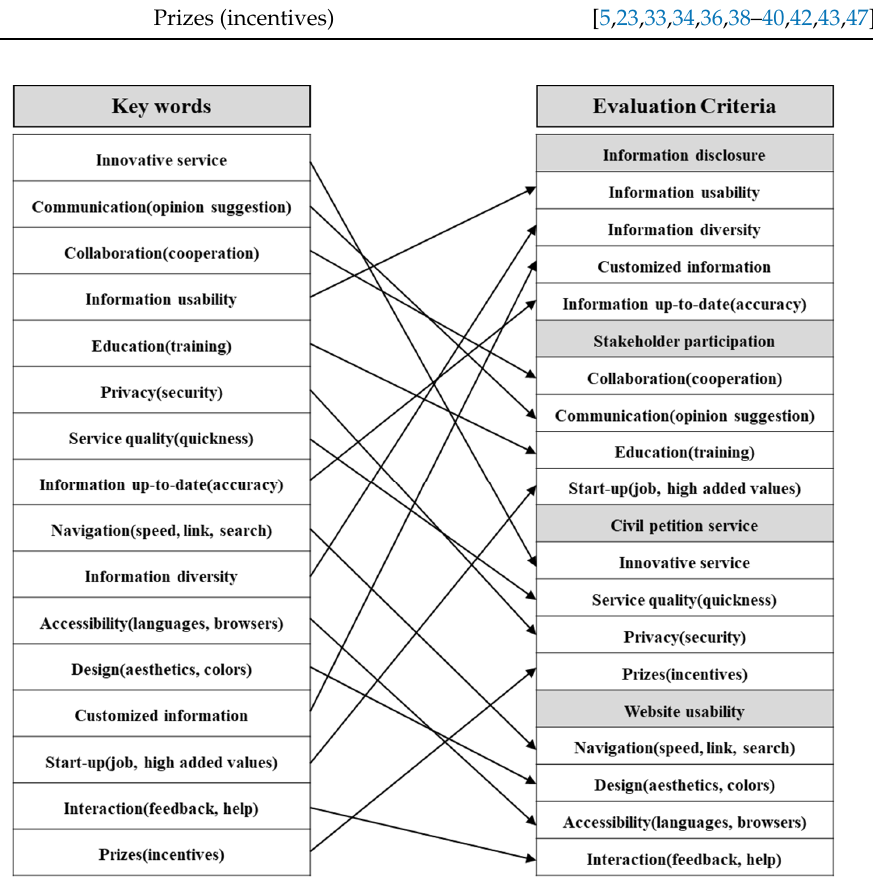
Figure 2. Diagram of key words and evaluation criteria